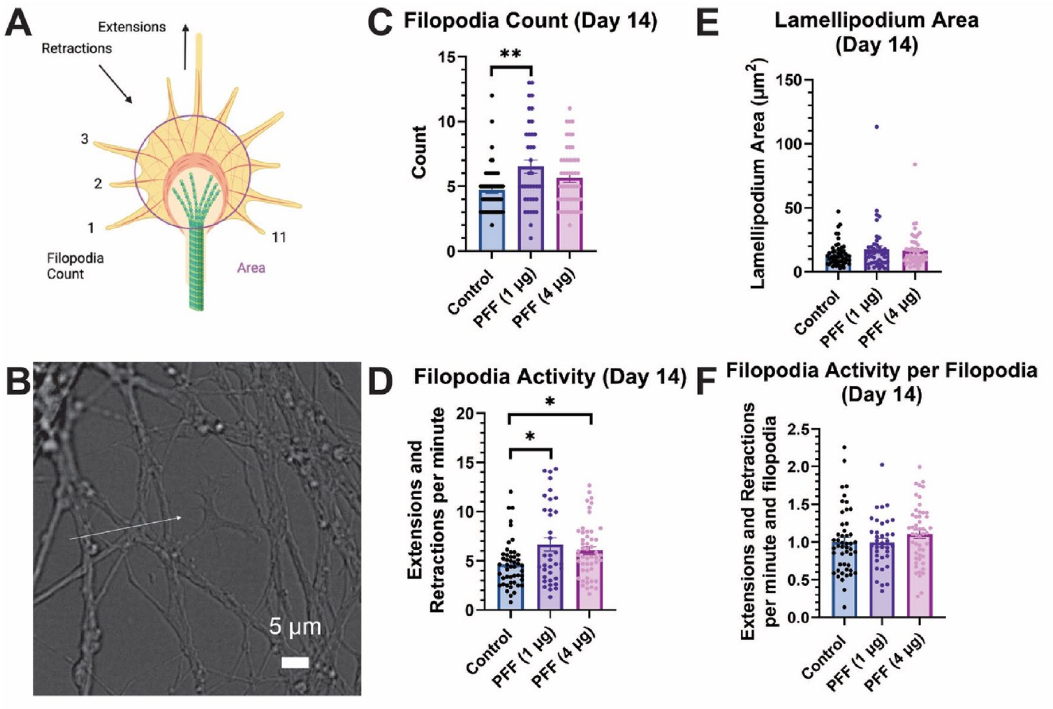
Figure 5. Growth cone quantitative assessment of ENS cultures observed on day 14 of culture. ( A ) Growth cone representative diagram. Figure made with Biorender. ( B ) Representative brightfield image of a growth cone. Day 14 measurement of ( C ) filopodia count, ( D ) filopodial activity (sum of extensions and retraction events per time passed), ( E ) lamellipodium area, ( F ) filopodial activity normalized per filopodia. Statistical analyses were conducted with either logarithmic ( C , E ) or 4th root ( D , F ) transformation and either general linear model ( D , E ) or multilevel model adjusting for experimental replicate and well ( F ) or replicate alone ( C ). N = 4, m = 11–12, growth cones = 43–54. Each dot represents a growth cone. Error bars = SEM. (* p < 0.05, ** p < 0.01, *** p <